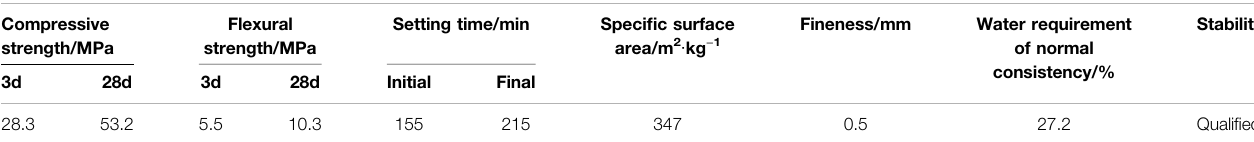
TABLE 3 | Property indexes of reference cement.